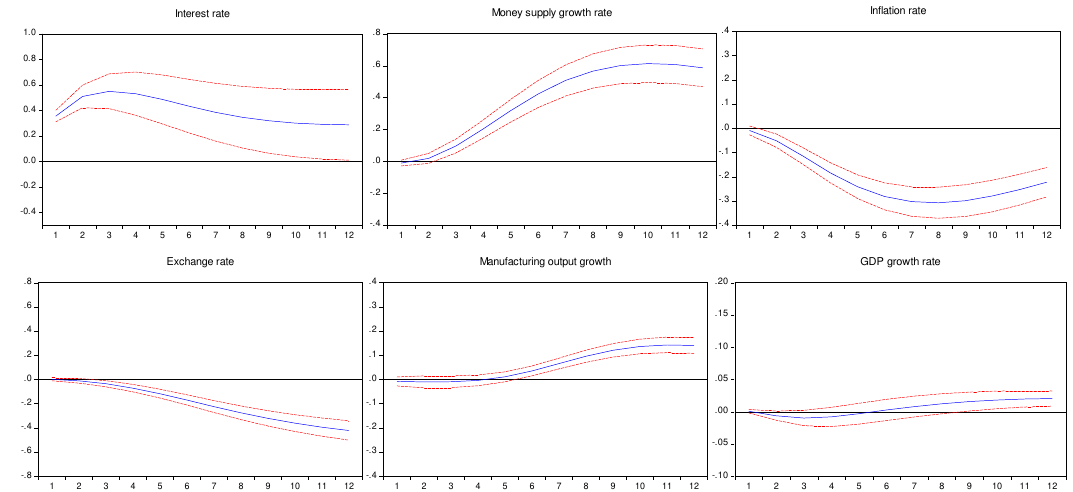
Figure 3. Responses of selected variables to an interest rate shock in